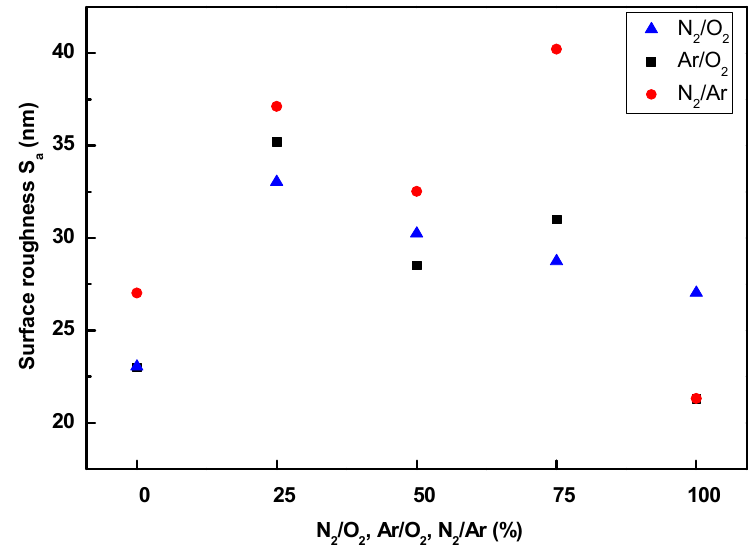
Figure 14. Surface roughness as a function of plasma treatment time for PU treated using gas mixtures.